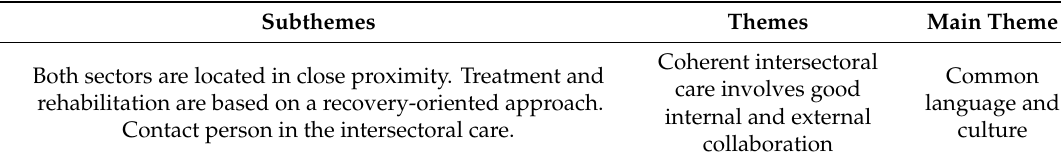
Intersectoral care as experienced by healthcare professionals: subthemes, themes, and main theme.